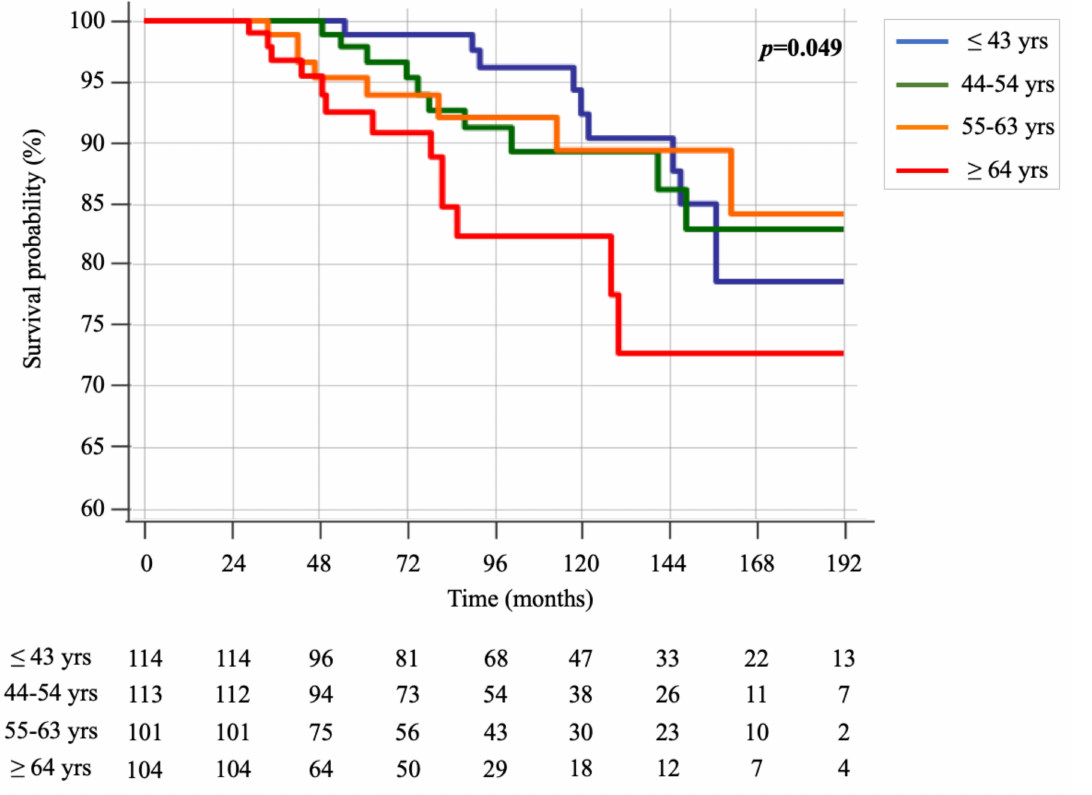
Figure 2. Kaplan-Meier survival curves of groups, divided into quartiles of age ( ≤ 43 yrs, 44–54 yrs, 55–63 yrs and ≥ 64